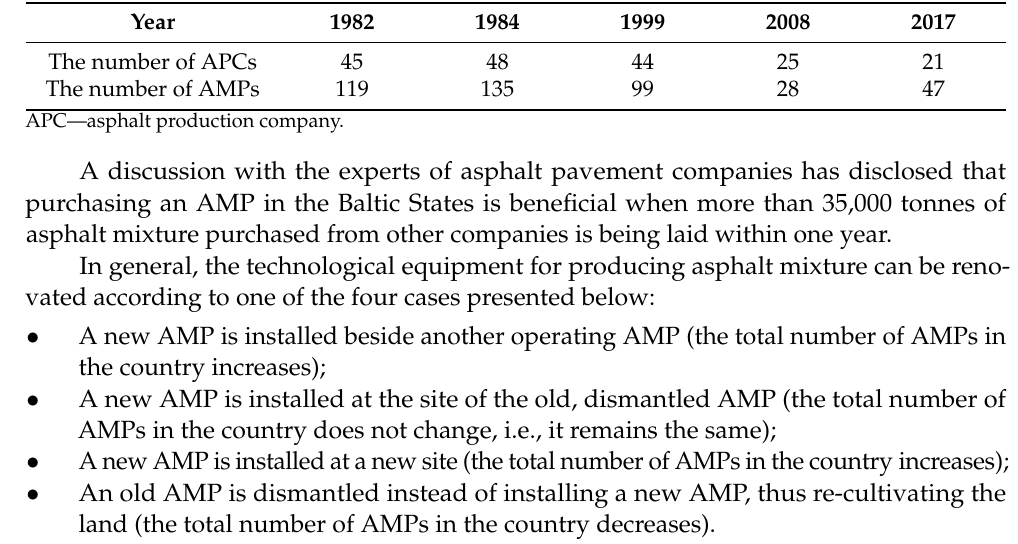
Table 3. The number of APCs and AMPs in